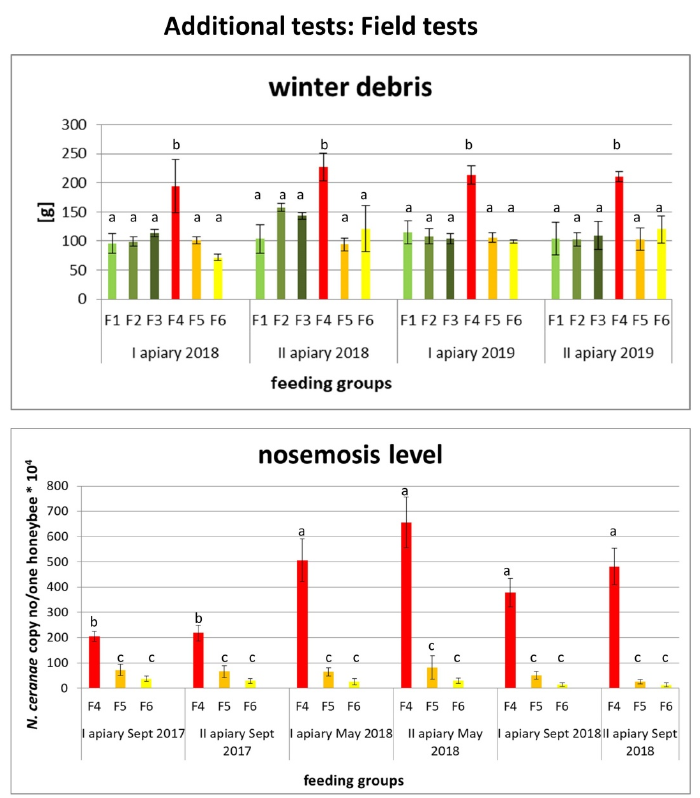
Figure 4. Results of additional tests: Field tests. Data illustrated winter debris and average levels of nosemosis in honeybee colonies fed with pure sucrose solution without extraxts (F1 and F4 groups with uninfected and Nosema -infected colonies, respectively), with E. senticosus extract in the concentration of 0.4 mg/mL (F2 and F5 groups with uninfected and Nosema -infected colonies, respectively) and with E. senticosus extract in the concentration of 0.9 mg/mL (F3 and F6 groups with uninfected and Nosema -infected colonies, respectively). Error bars denote a confidence interval (CI). In each apiary, colonies were divided into 6 groups, i.e., (F1) 5 colonies as control, untreated group with healthy honeybees, (F2) 5 colonies with healthy honeybees fed with E. senticosus extract in the concentration of 0.4 mg/mL, (F3) 5 colonies with healthy honeybees fed with E. senticosus extract in the concentration of 0.9 mg/mL, (F4) 5 untreated colonies with Nosema -infected honeybees, (F5) 5 colonies with Nosema -infected honeybees fed with E. senticosus extract in the concentration of 0.4 mg/mL and (F6) 5 colonies with Nosema -infected honeybees fed with E. senticosus extract in the concentration of 0.9 mg/mL. 2.2.2. Results of LIVE/DEAD Tests and Nosema Spore Cell Wall Analysis under Scanning Electron Microscopy (SEM)